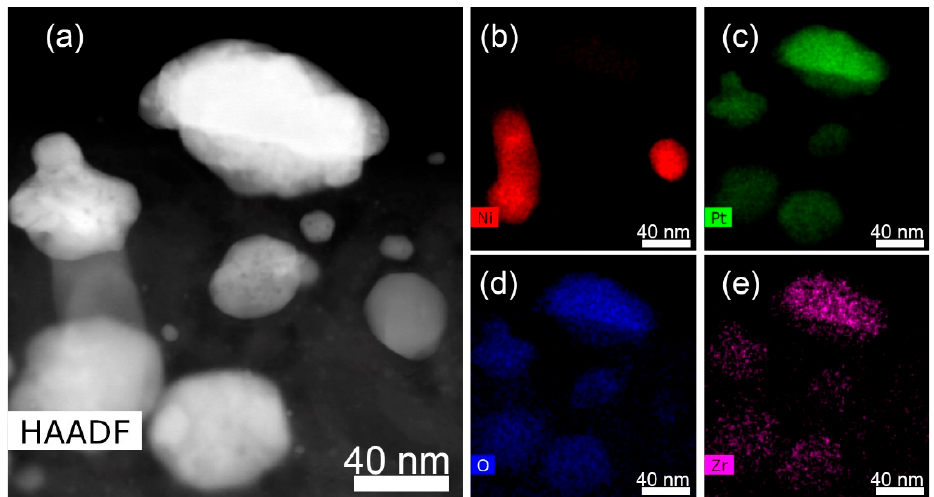
Figure 6. Elemental distribution on the CNF surface: ( a ) STEM HAADF image of particles; ( b – e ) corresponding elemental maps for sample 3 .